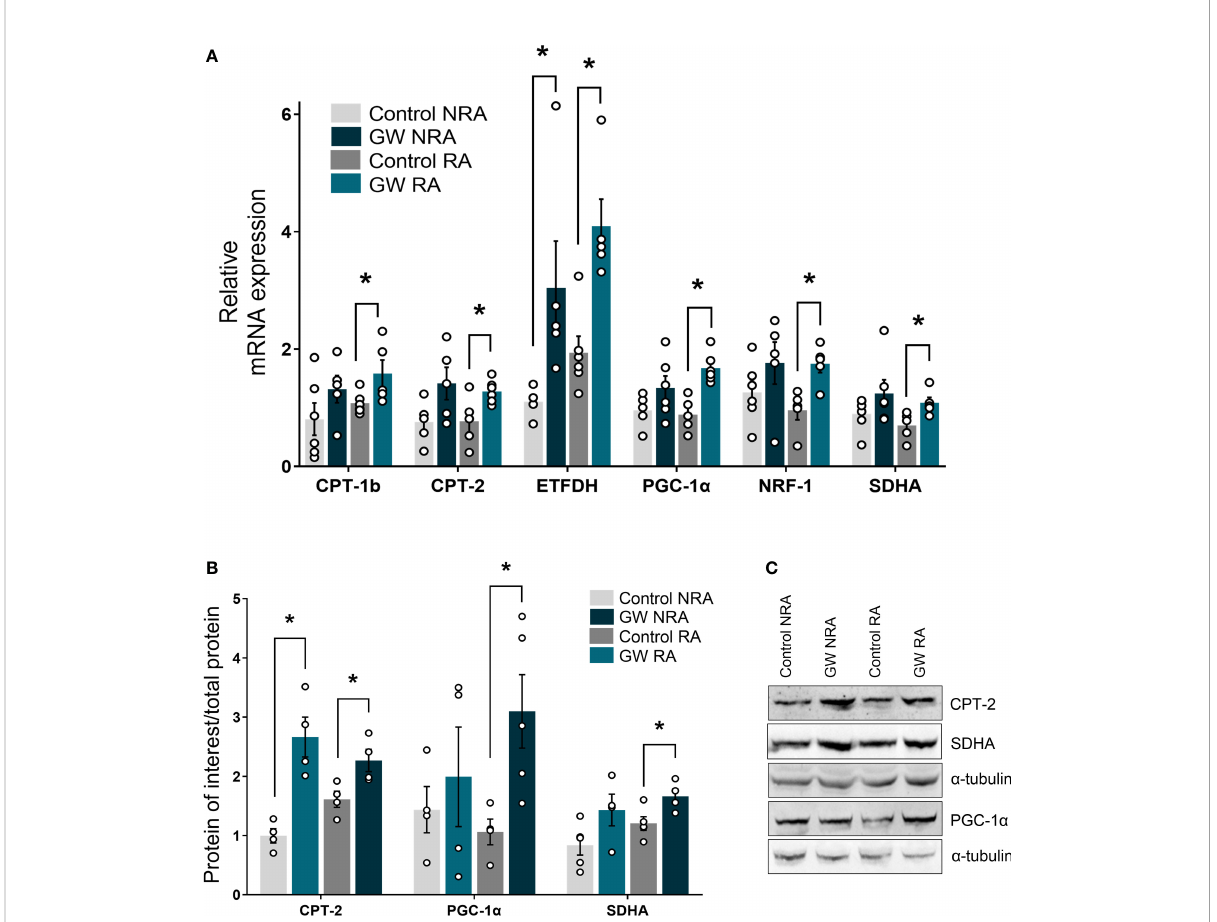
FIGURE 6 PPAR b / d upregulates genes of the FAO-dependent electron production and PGC-1 a /NRF-1 signaling during I/R. mRNA expression of (A) carnitine palmitoyl transferase 1 (CPT-1), carnitine palmitoyl transferase 2 (CPT-2) and electron transfer fl avoprotein dehydrogenase (ETFDH), PPAR co-factor a (PGC-1 a ), nuclear respiratory factor 1 (NRF-1) and succinate dehydrogenase subunit A (SDHA). mRNA expression was determined in the NRA and the RA of ex vivo I/R-subjected hearts by qPCR and normalized to b -actin. Results are presented as means ± SEM of 5-6 independent experiments (B) CPT-2, PGC-1 a and SDHA protein levels quanti fi ed by densitometric analysis and (C) representative blot images for each protein. Results are presented as means ± SEM of 4-5 independent experiments. RA, risk area; NRA, non-risk area; GW, pretreated with PPAR b / d agonist GW0742. *p <